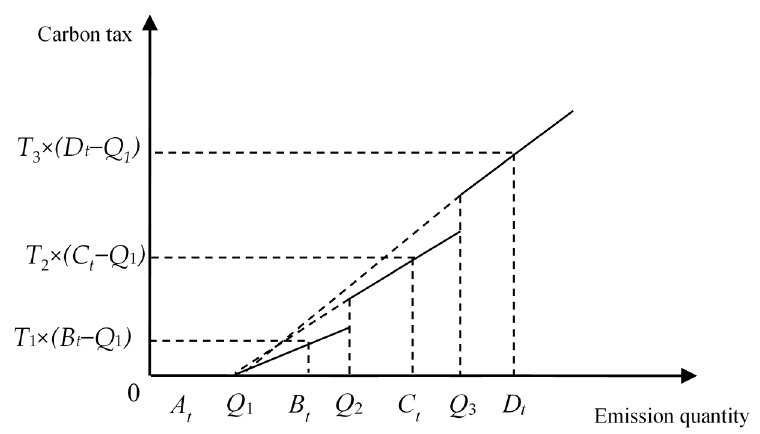
Figure 5. The full progressive tax rate with a threshold.